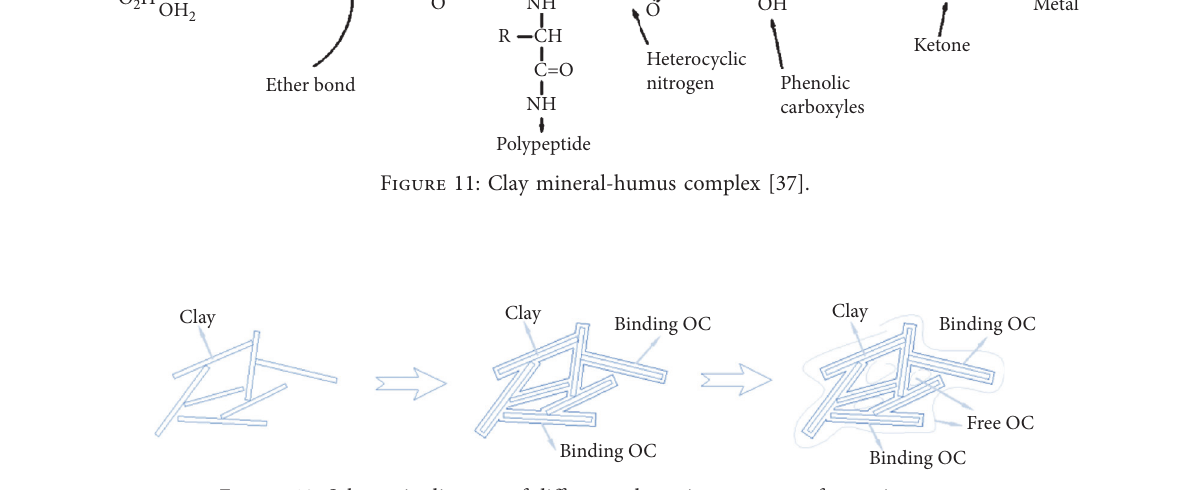
Figure 12: Schematic diagram of different adsorption patterns of organic